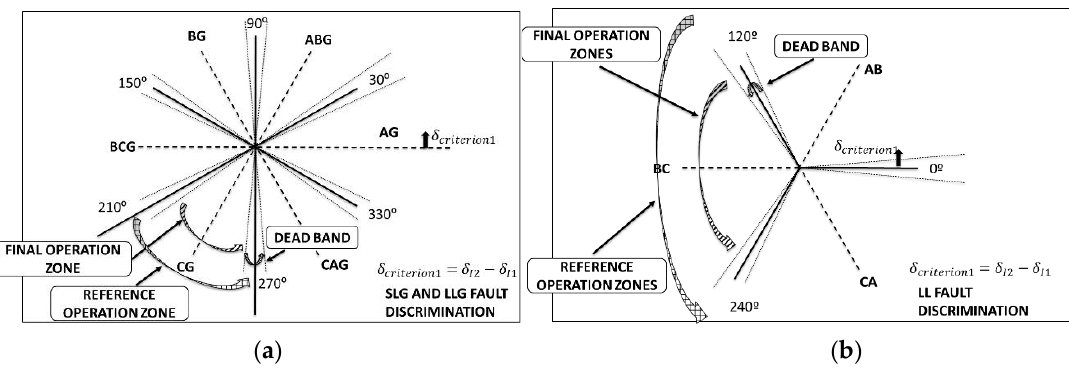
Figure 11. Criterion 1 for single line to ground and line to line to ground faults ( a ) and line to line faults ( b ).